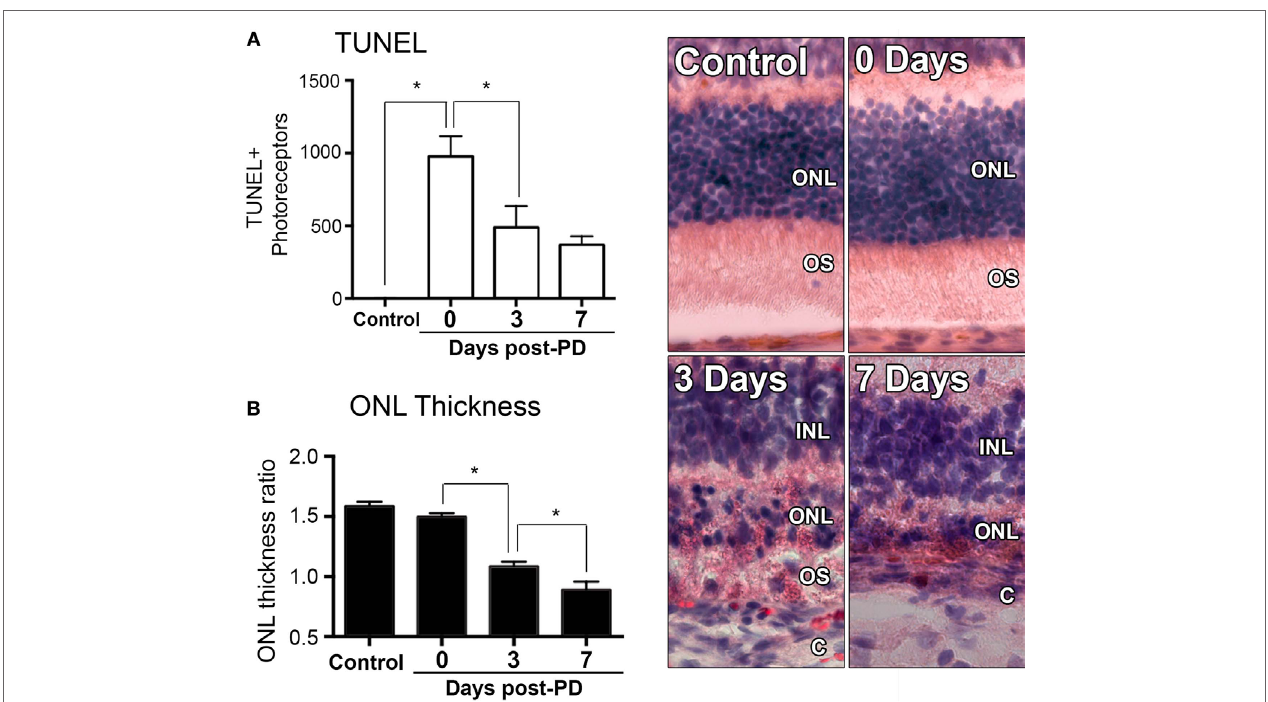
FigUre 1 | Changes in photoreceptor apoptosis and degeneration following photo-oxidative damage (PD). (a) TUNEL + photoreceptors were quantified across retinal sections for each replicate in each group. There was immediately increase in TUNEL + photoreceptors following PD, at 0 days, which remained significantly elevated at 3 and 7 days post-exposure ( P < 0.05). (B) ONL thickness was averaged across retinal sections and expressed as a ratio of the total retinal thickness, for each sample. There was a progressive decrease in ONL thickness from 0 to 7 days post-exposure ( P < 0.05). Representative images are taken from the superior retina, approximately 500 µm from the optic nerve head. The data depict a sample size of n = 5 per group. Asterisks equates to P -value of < 0.05, as determined by Tukey’s post hoc test. ONL, outer nuclear layer; OS, outer segments; INL, inner nuclear layer; C,